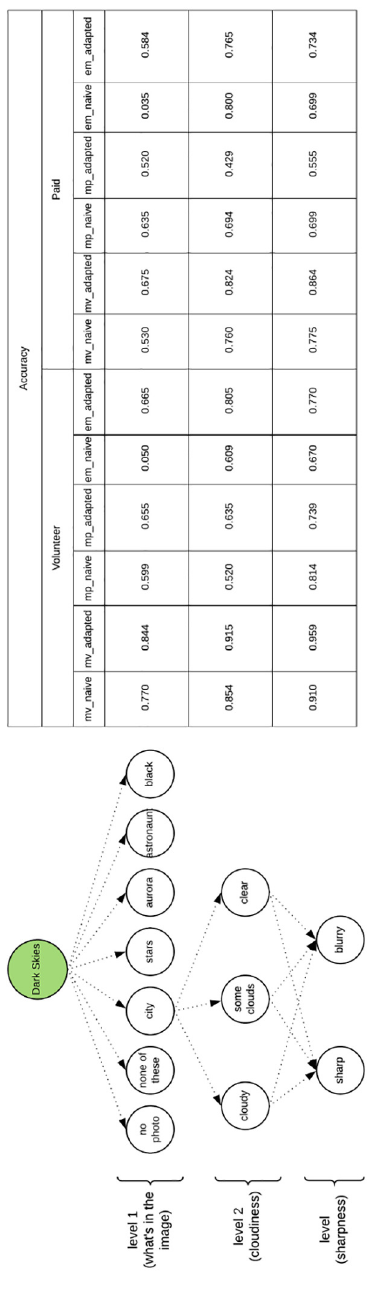
Figure 9. Accuracy by node level